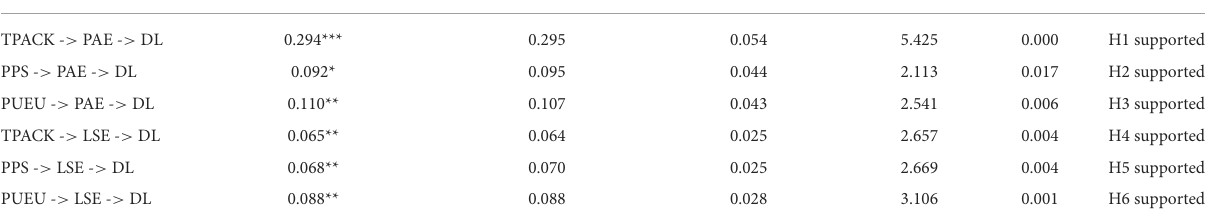
TABLE 9 Significance of effects path ( n =